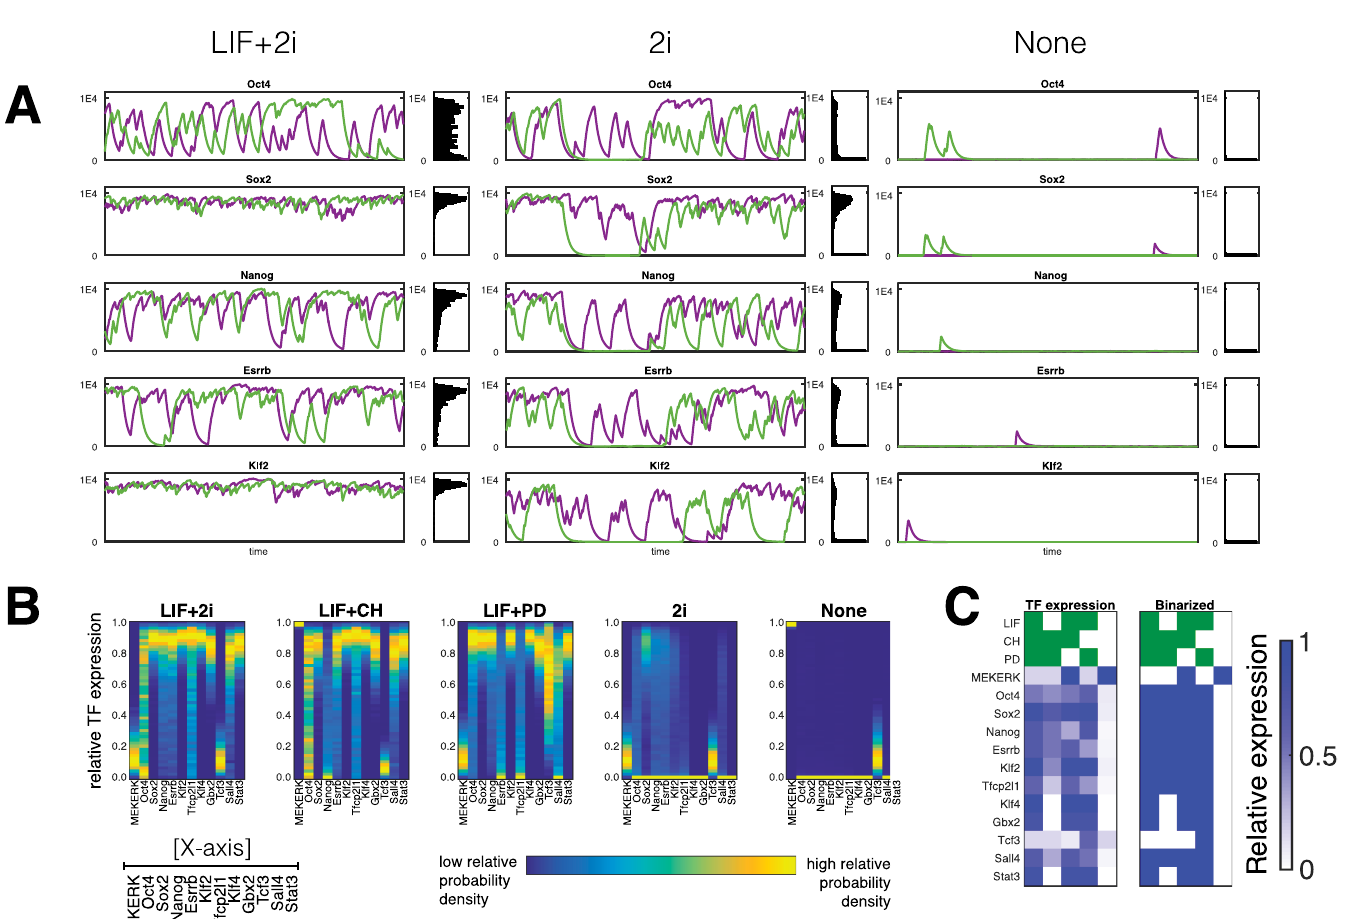
Fig 4. Gene expression profiles of pluripotency factors predicted by individual-based simulations. The intermediate switching regime is chosen to be presented as it is the regime which best captures the experimentally measured distributions [7, 8]. (A) Shown are two representative trajectories and full distributions of select few transcription factors under three different conditions generated by individual-based simulations. Typical lifetime for pluripotency transcription factors [25–28] ( * 1 hr) is used for setting the absolute time-scale of simulations (B) Gene expression profile showing the near quantitative agreement with results of PDMP simulations shown in Fig 3. (C) Gene expression profile of individual-based model, for comparison with the PDMP and experimental benchmark shown in Fig 2.